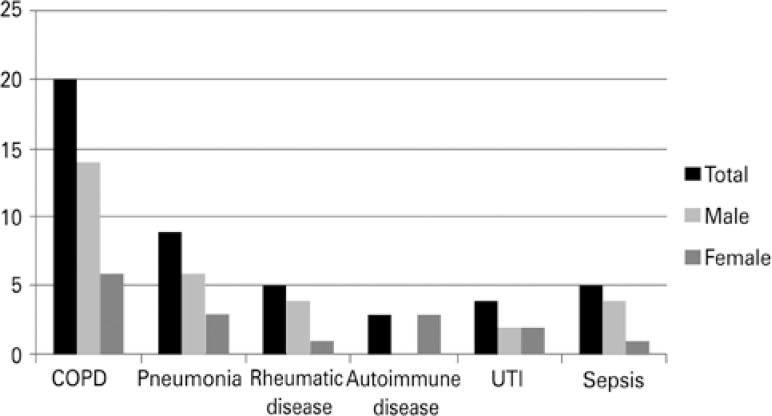
Distribution of infectious conditions in the sampleCPOD: chronic pulmonary obstructive disease; UTI: urinary tract infection.